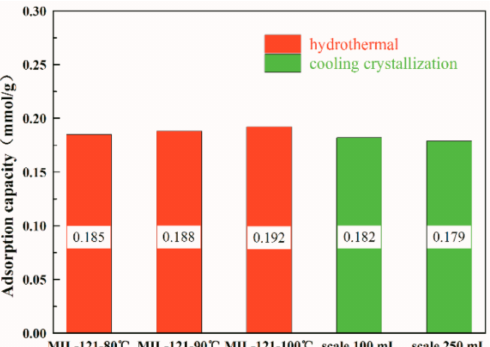
Figure 8. The adsorption performance diagram of MIL-121 obtained under different experimen- tal